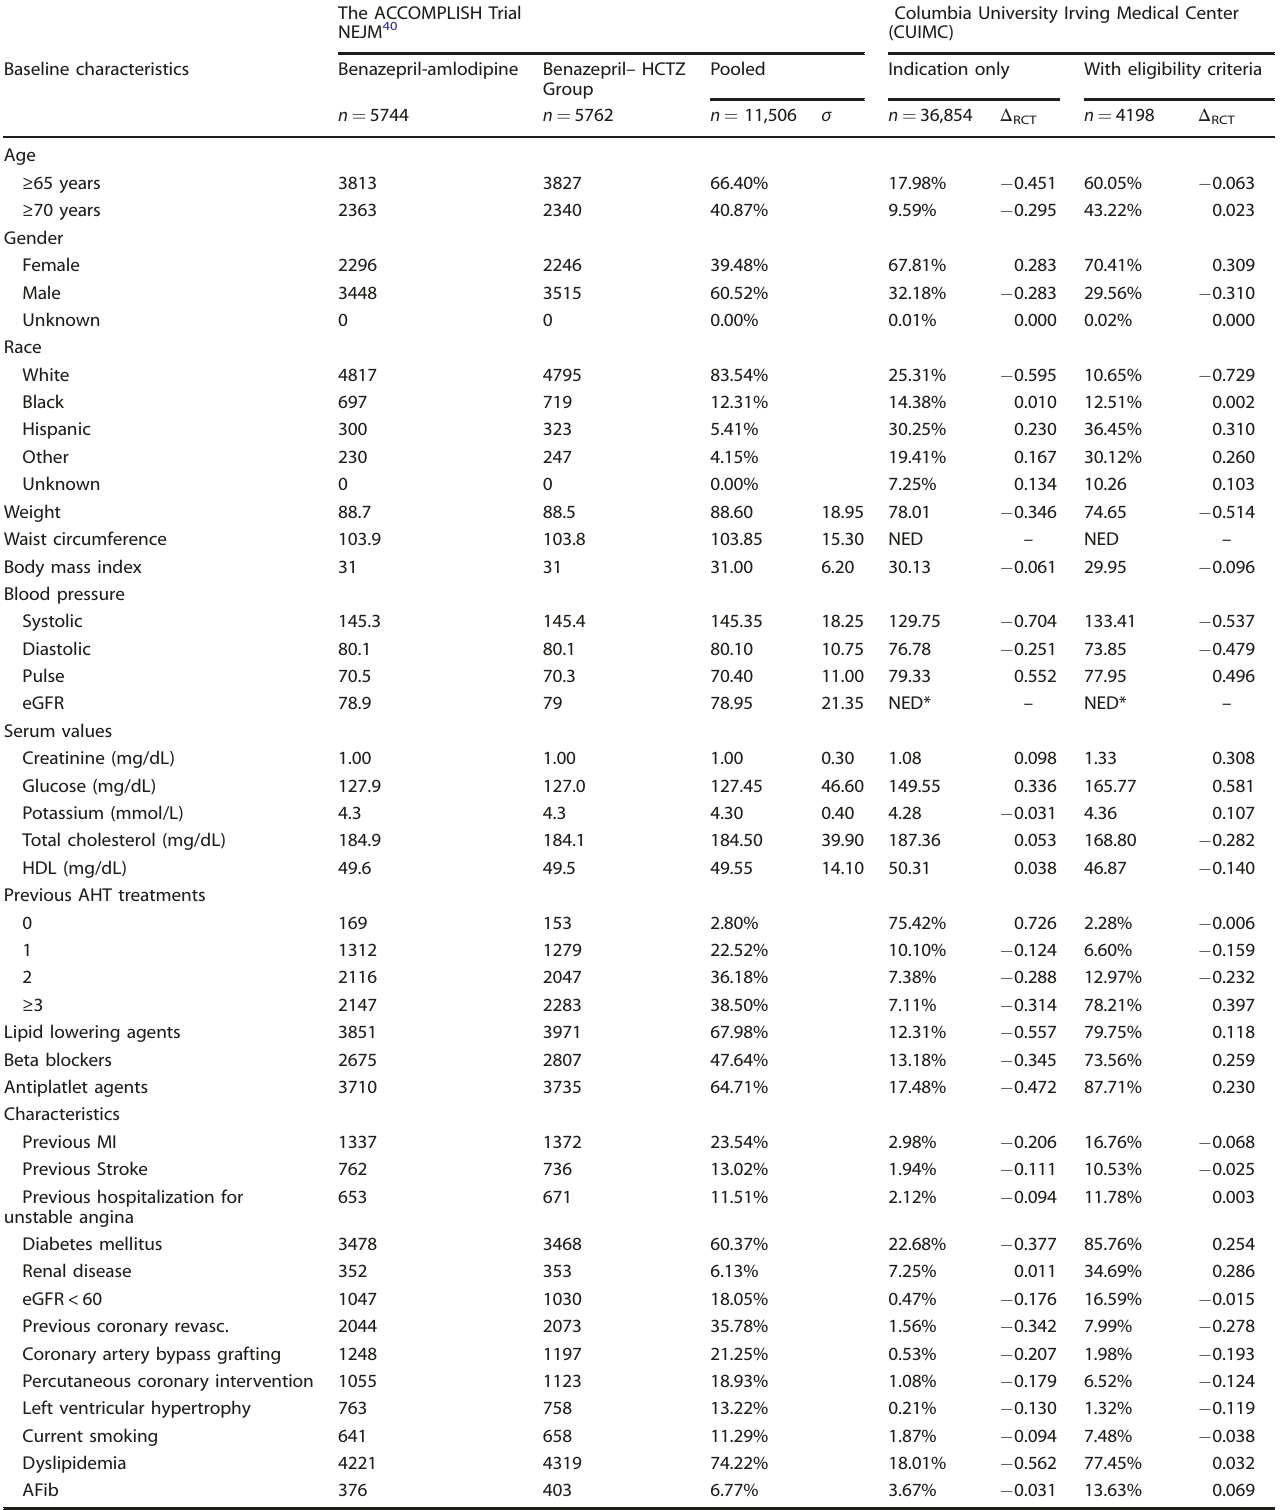
Table 4. Results for benazepril-amlodipine vs. benazepril and hydrochlorothiazide (HCTZ) trial (ACCOMPLISH). The ACCOMPLISH Trial NEJM